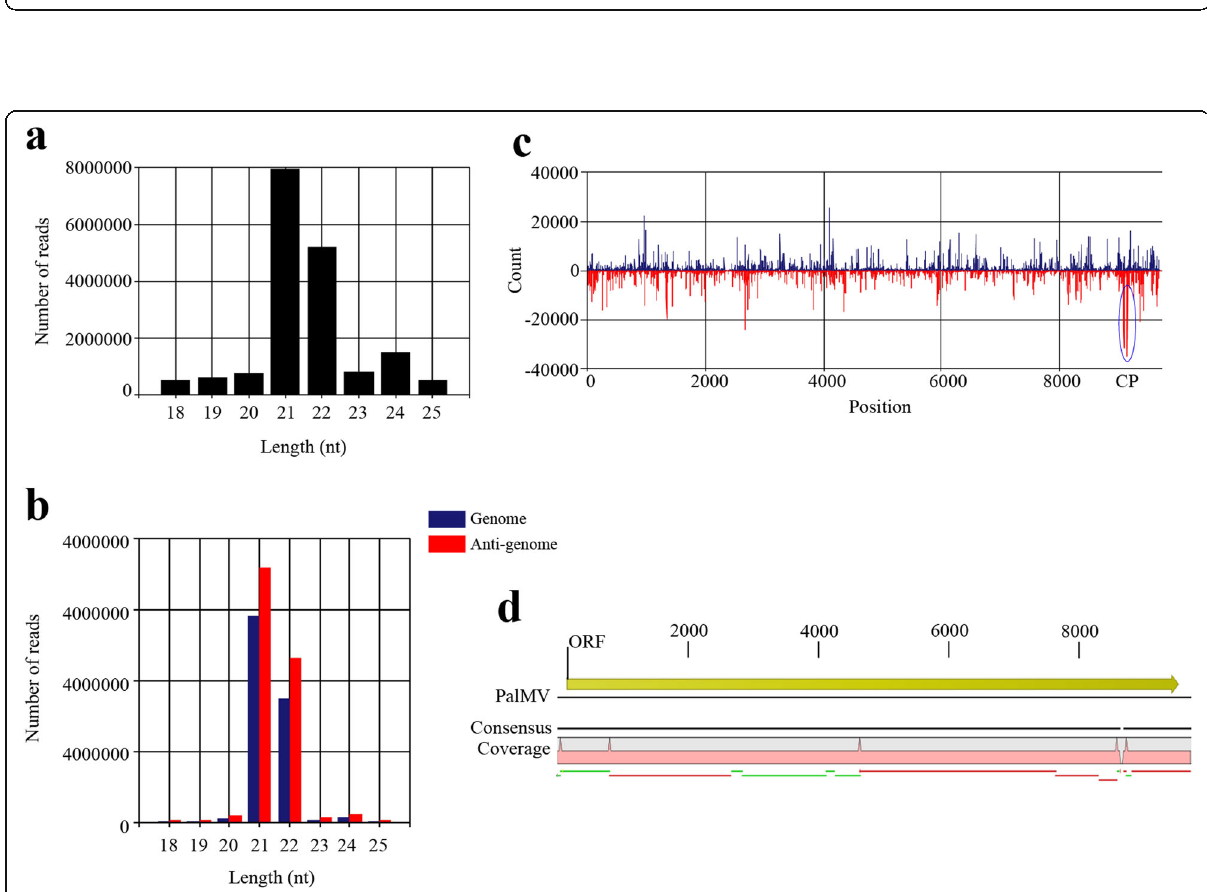
Fig. 1 Comparison of healthy and naturally infected Pennisetum alopecuroides plants. a Naturally infected plants (right) showing a dwarfing phenotype along with delayed flowering compared with healthy plants (left). b Close-up image showing mosaic symptom on leaves